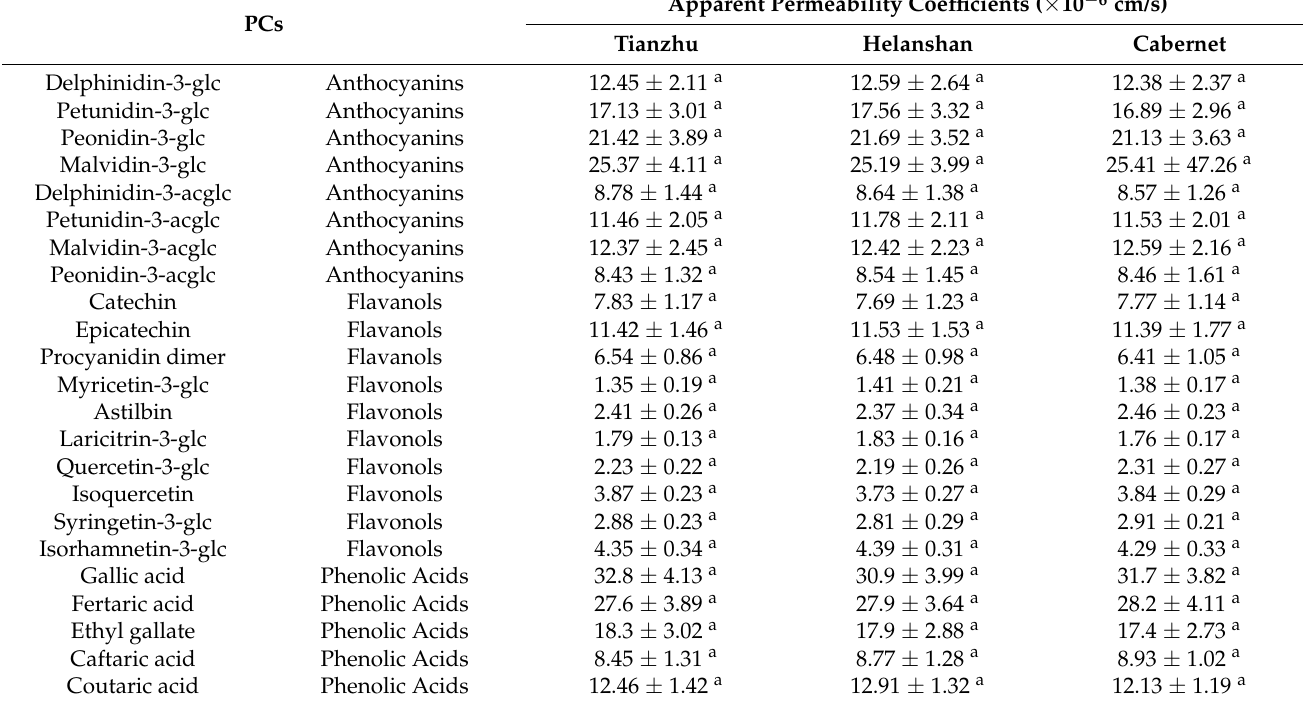
Table 2. Apparent permeability coefficients of